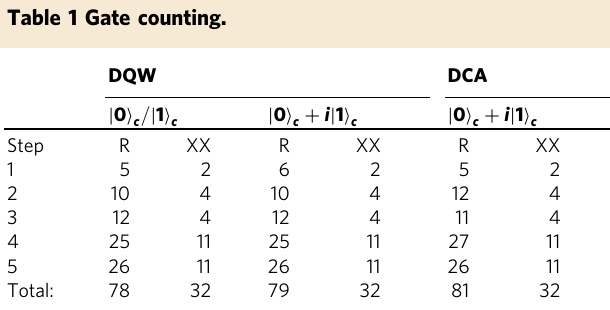
Fig. 3 Circuit implementation of quantum walks on a trapped-ion processor and its time evolution. a Circuit diagram for a DQW and DCA. Each dashed block describes one step in the quantum walk. b Discrete-time Quantum Walk. Comparison of the experimental results (left) and the theoretical quantum- walk probability distribution (right) for the fi rst fi ve steps with initial particle state b i and b iv ψ j i ψ j i ¼ 0 j i þ i 1 j i , and position state x ¼ 0 j i . c Output of a step-5 Dirac Cellular Automaton for θ 1 = 0 and, c i and c iv θ 2 = π /4, c ii and c v θ 2 = π /10 and c c c j c iii and c vi θ 2 = π /20 with the initial state Ψ in